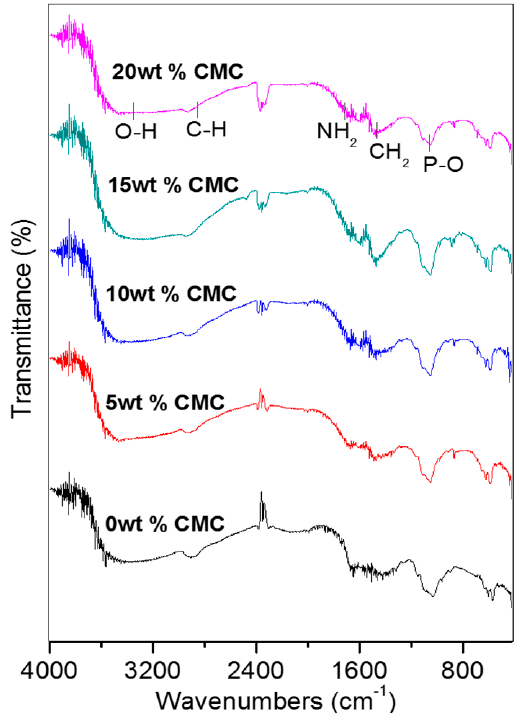
Figure 1. FTIR spectrum of nanocomposite n-HA/Ch/CMC with variation in CMC composition.